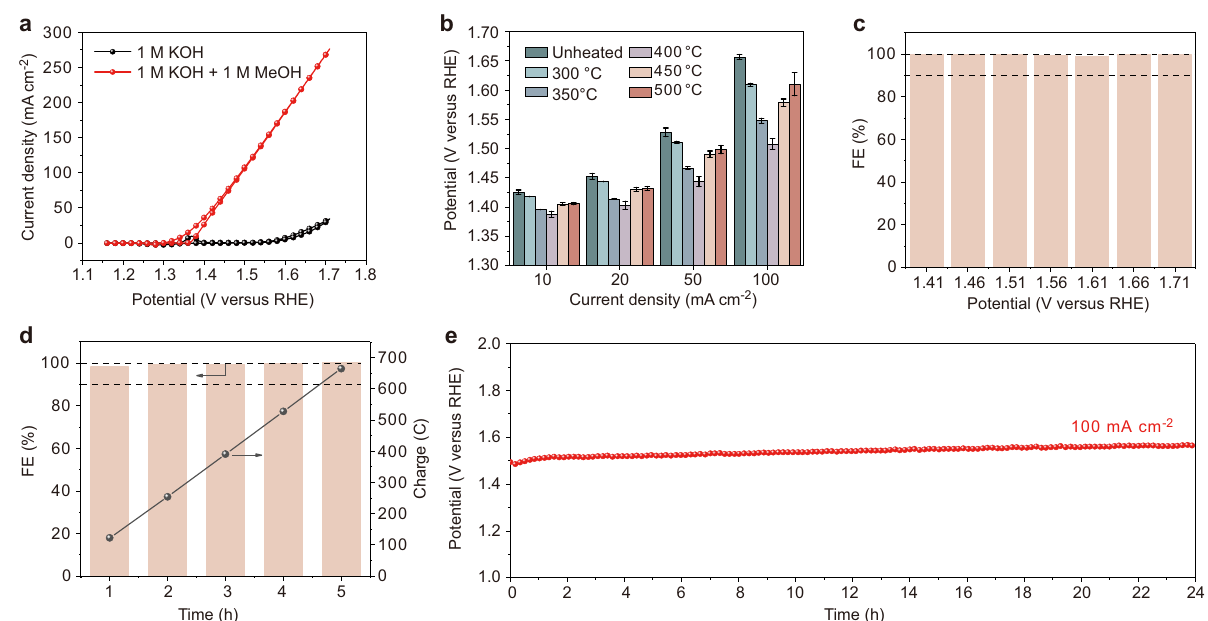
Fig. 2 | Electrocatalytic performance of nickel boride/nickel catalyst for MOR. a CV curves of NiB-400 in 1.0M KOH electrolyte with and without 1M methanol. b Comparisonoftheappliedpotentialsrequiredtoachievevariedcurrentdensities in 1.0M KOH with 1M MeOH electrolyte for samples annealed at different tem- peratures. c Faradaic ef fi ciency of formate obtained after 1h of electrolysis at